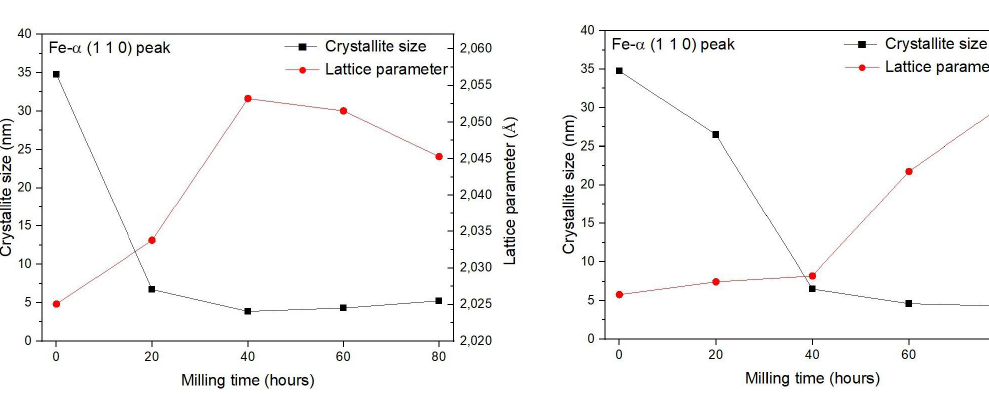
Figure 14. Detail of the (110) Fe-α peak analysis for different milling Fe-15at.%Nb samples with hexane PCA.